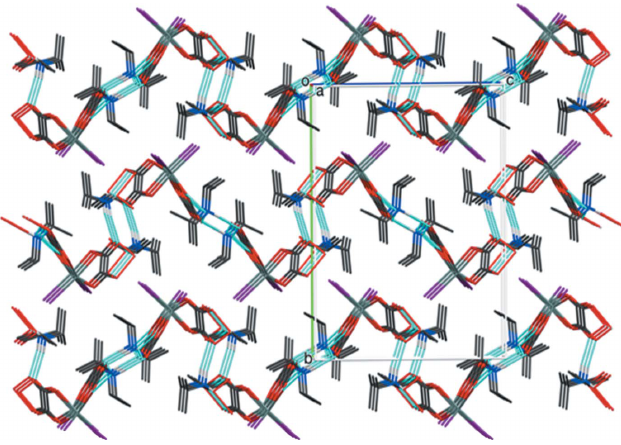
Figure 3 The crystal packing for (I) viewed down